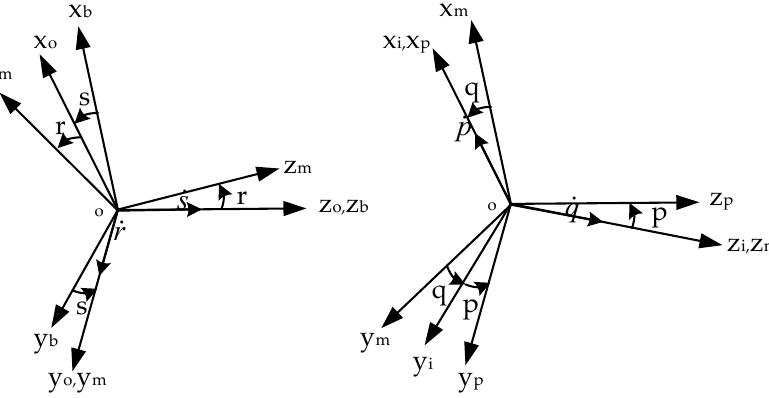
Figure 4. High-precision four-gimbal platform INS structure.